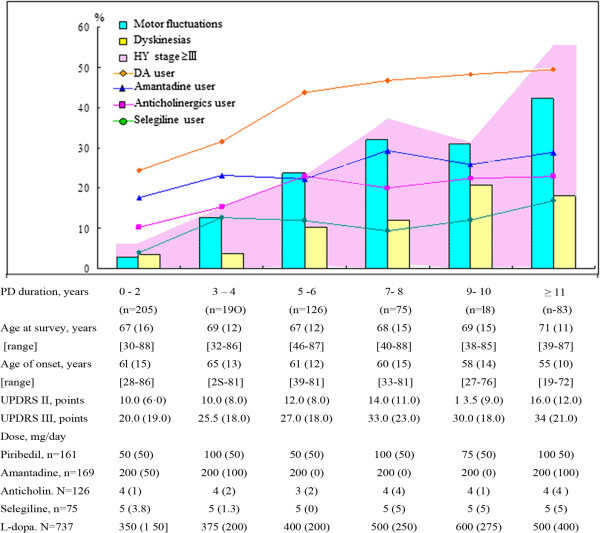
Prevalence of Motor Complications and Medication uses by PD Duration among L-dopa/DCI Users. Abbreviations: Anticholin, Anticholinergics; IQ, Interquartile range; DA, dopamine agonists; UPDRS, Unified Parkinson’s Disease Rating Scale; Values are given as median (IQ) unless stated otherwise.